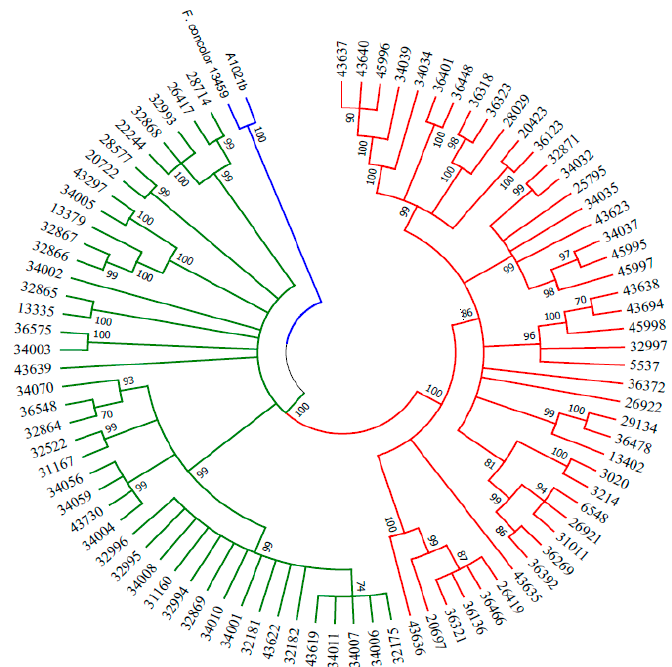
Figure 3. Maximum likelihood tree inferred from ITS-TEF1-CAL1 concatamers. Phylogenetic analysis including A1021B, FIESC members and F. concolor as outgroup inferred using the maximum likelihood method (MEGA7). The bootstrap consensus tree inferred from 1000 replicates is taken to represent the evolutionary history of the taxa analyzed.